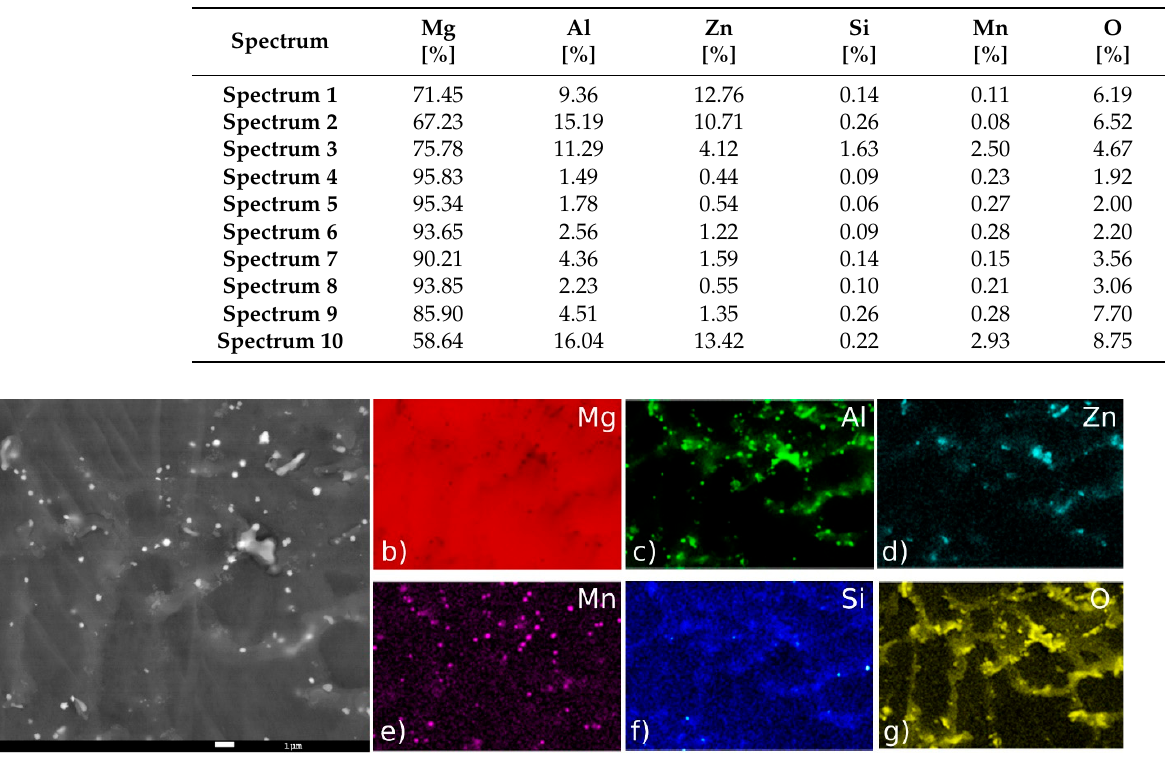
Figure 9. Mapping of elements across weld metal no. 1; ( a ) weld metal, ( b ) Mg, ( c ) Al, ( d ) Zn ( e ) Mn, ( f ) Si, ( g ) O.